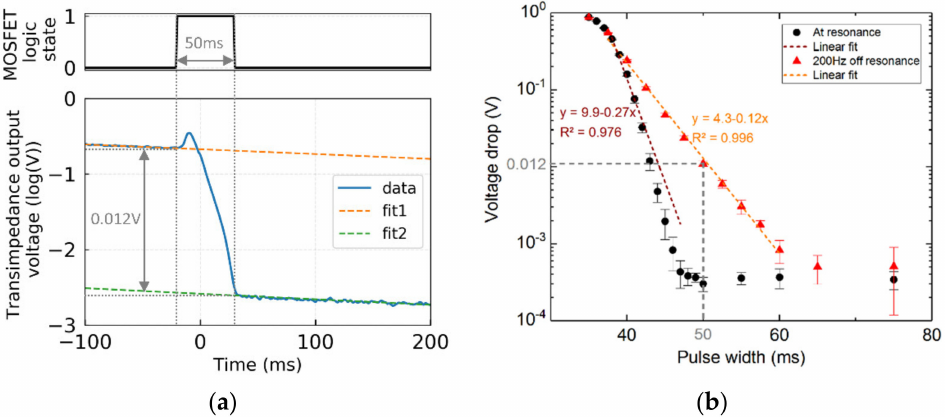
Figure 7. ( a ) Example of the fitting procedure for a pulse width of 50 ms. The log-plotted data are linearly fitted before damping (yellow dashed line) and just after the damping (green dashed line). The voltage drop is obtained by subtracting the intercept of the two linear curves. ( b ) Voltage drop, measured at the output of the transimpedance amplifier (TA), as a function of the pulse width sent to the MOSFET gate. The experiment was realized at resonance (black dots) and 200 Hz off resonance (red triangles). The errors bars represent the standard deviation of the 10 measurements from Figure